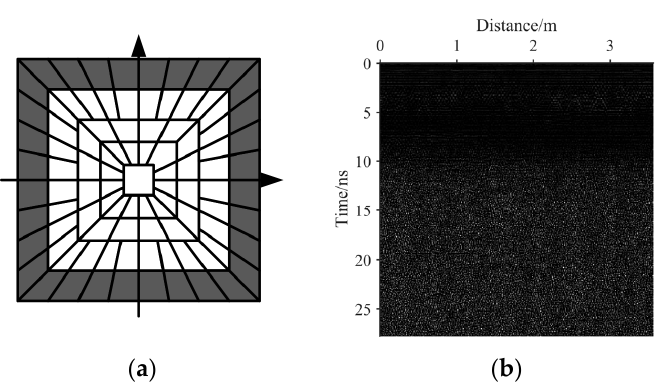
Figure 1. The real GPR image.